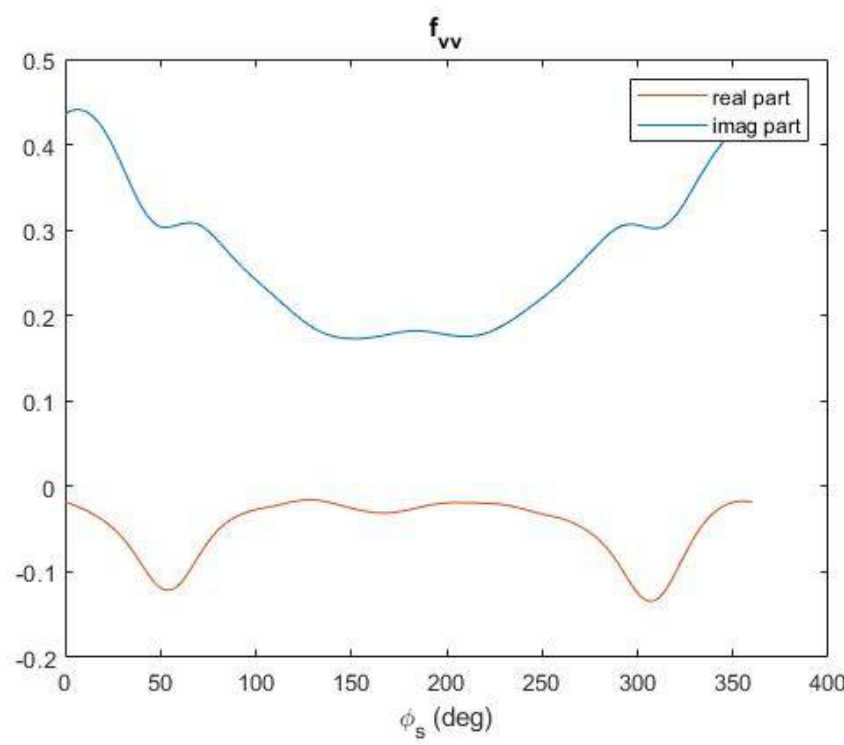
Remote Sens. 2022 , 14 , x FOR PEER REVIEW